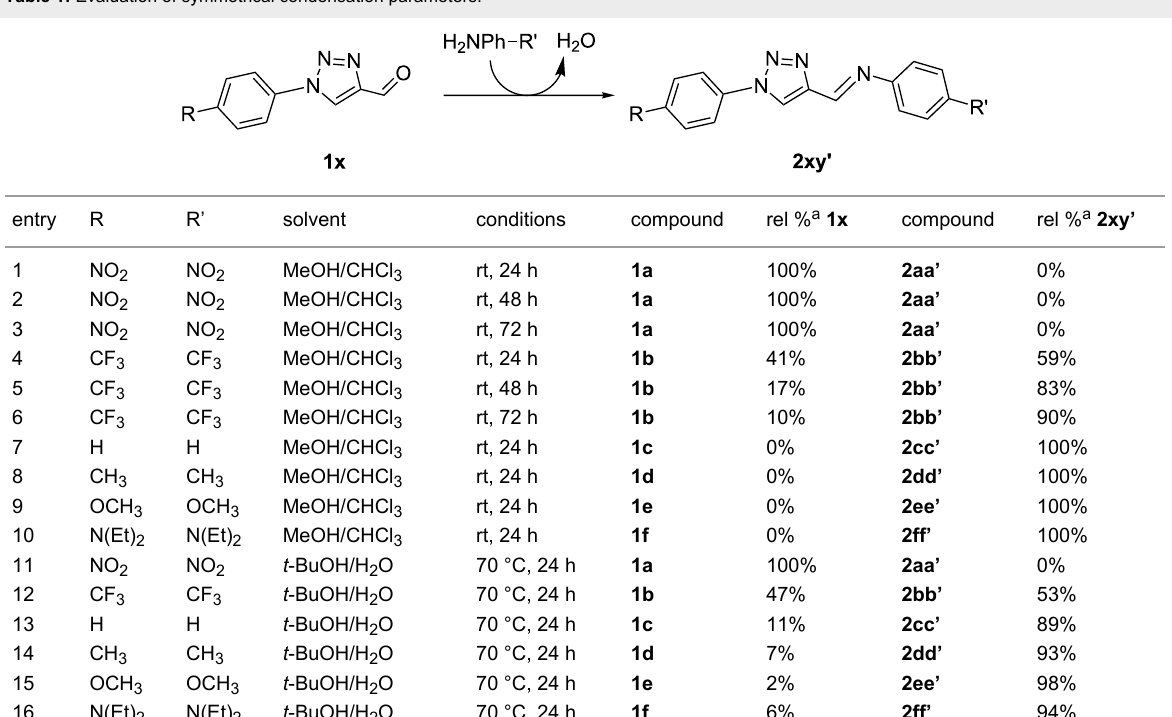
Table 1: Evaluation of symmetrical condensation parameters.